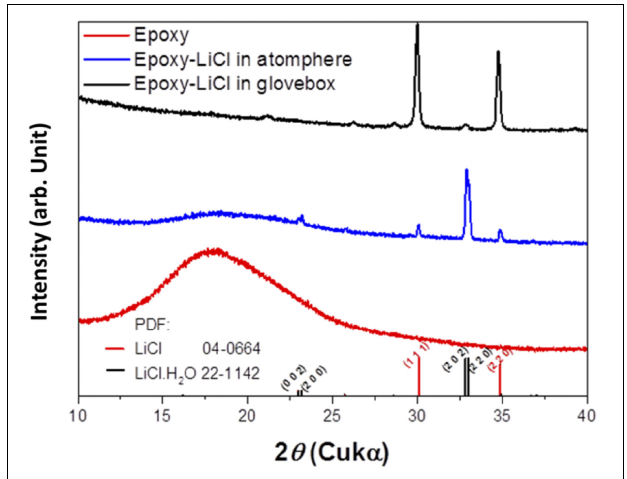
FIGURE 1 | X-ray diffraction (XRD) patterns of epoxy resin, epoxy resin with LiCl prepared under an air atmosphere, and epoxy resin with LiCl prepared in Ar-filled glove box.